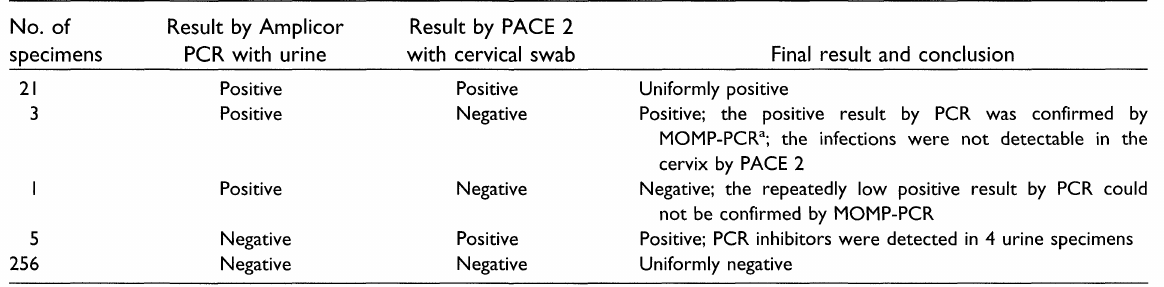
TABLE I. Analysis of results by Gen-Probe PACE 2 RNA hybridization with endocervical specimens and Roche Amplicor PCR with urine specimens in the detection of Chlamydia trachomatis from 286 women No.